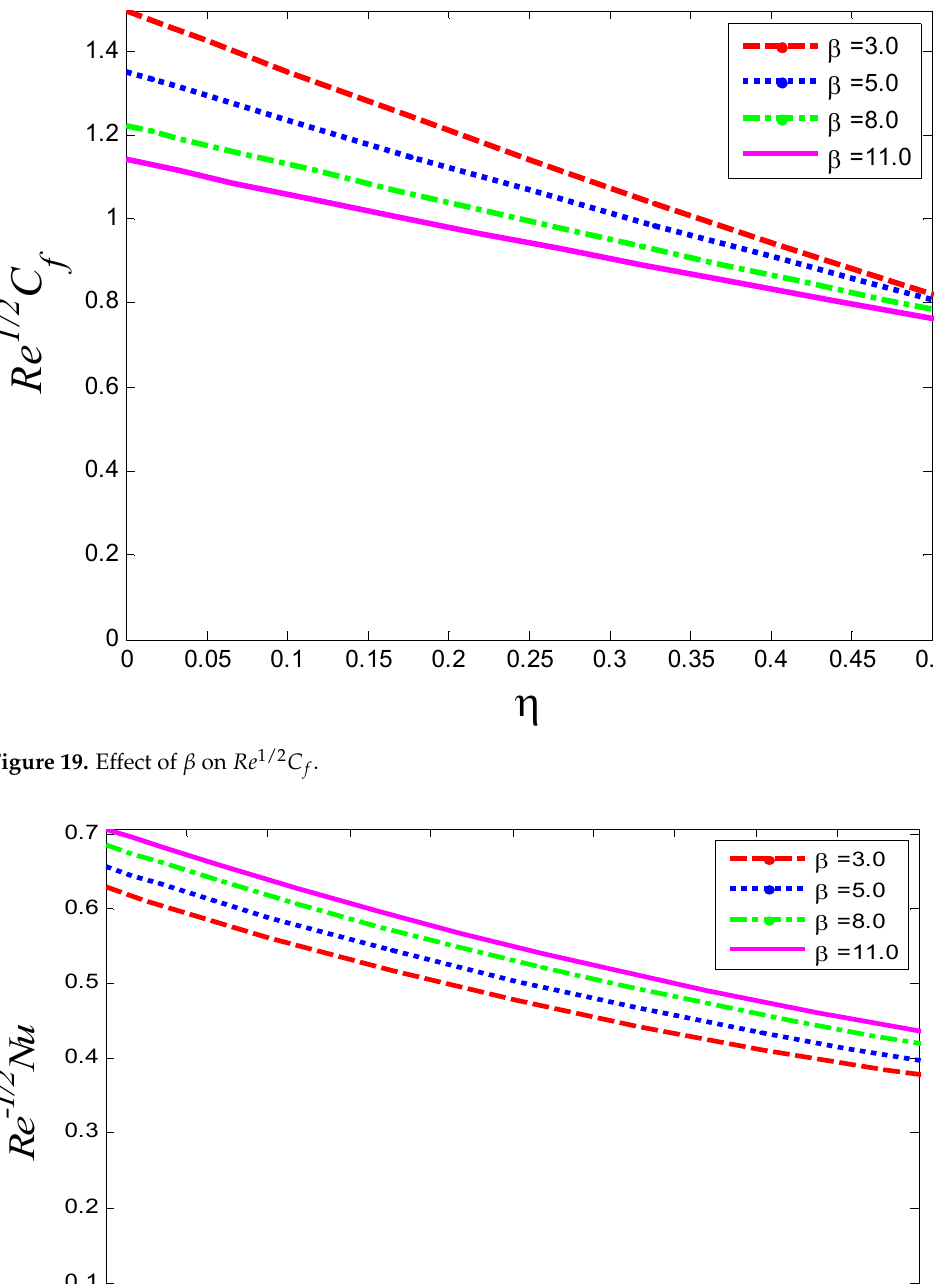
Figure 18. Effect of 𝑀 on 𝜃(cid:4666)𝜂(cid:4667) .